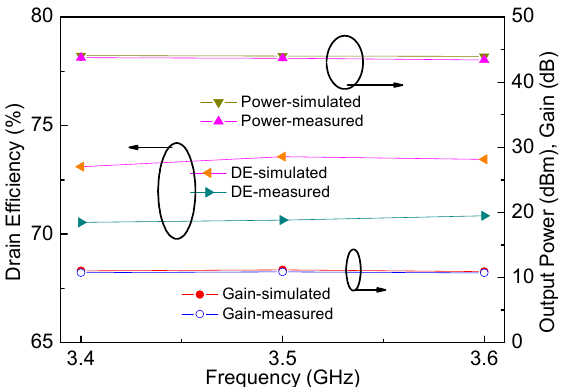
Figure 16. Simulated and measured output power, drain efficiency, and gain in saturation.